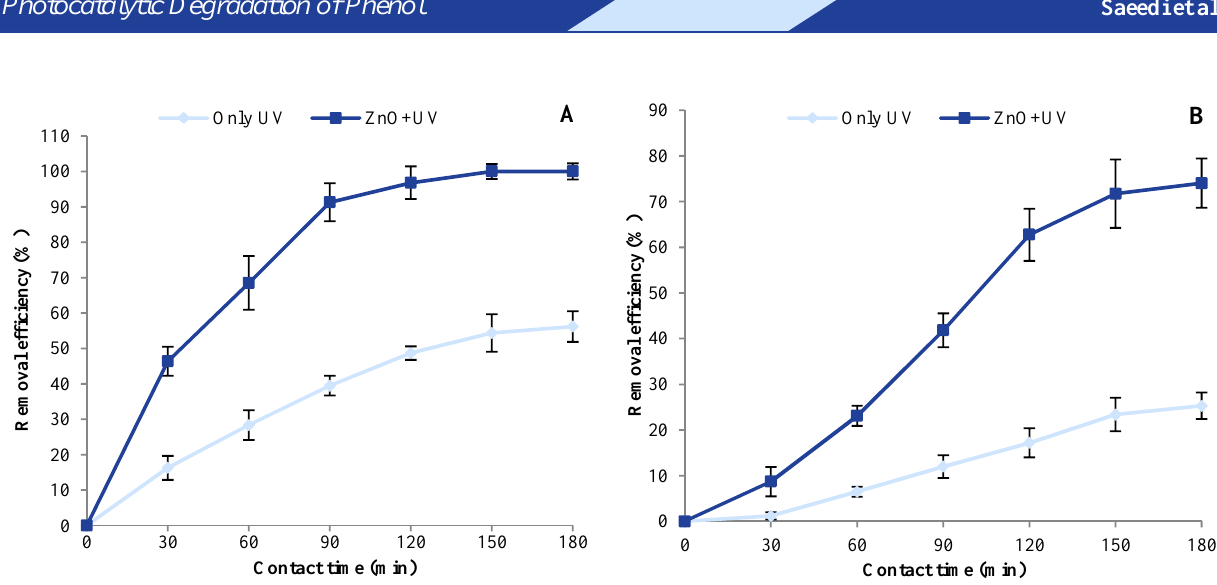
Figure 6. Comparison of the use of UV rays alone and the UV/ZnO process in the removal of phenol (pH = 3, NaCl = 10 g/l, radiation intensity = 3950 µw/cm 2 , and (a) C